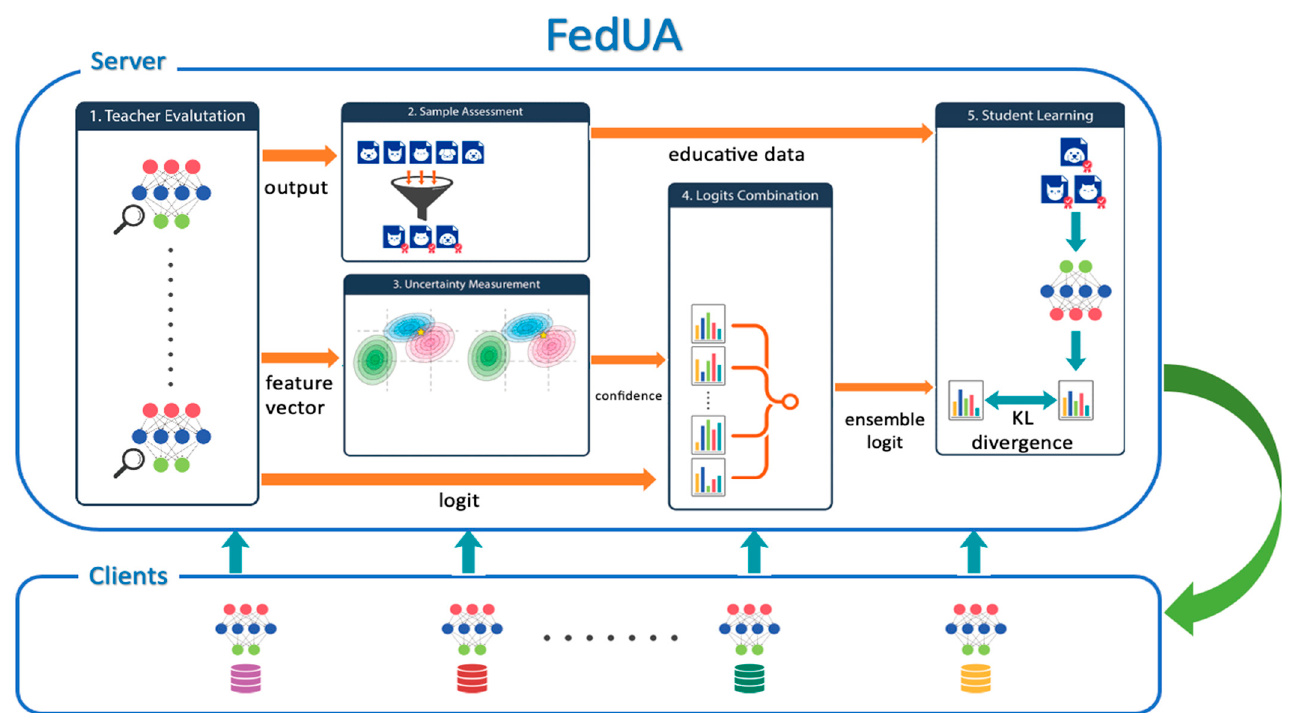
Figure 6. The schematic diagram and the information fl ow of our proposed FedUA.